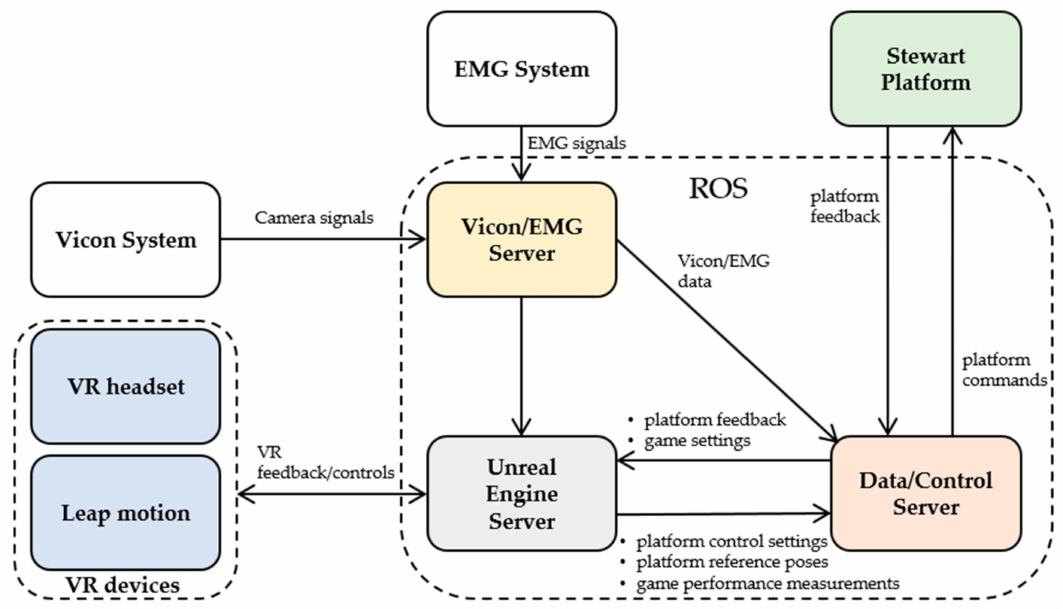
Figure 2. The system functional architecture of DORIS. The right dashed box includes all the main modules which use ROS (Robotic Operating System) as middleware. These subsystems exchange di ff erent kind of messages, whose main conveyed information is concisely reported over the